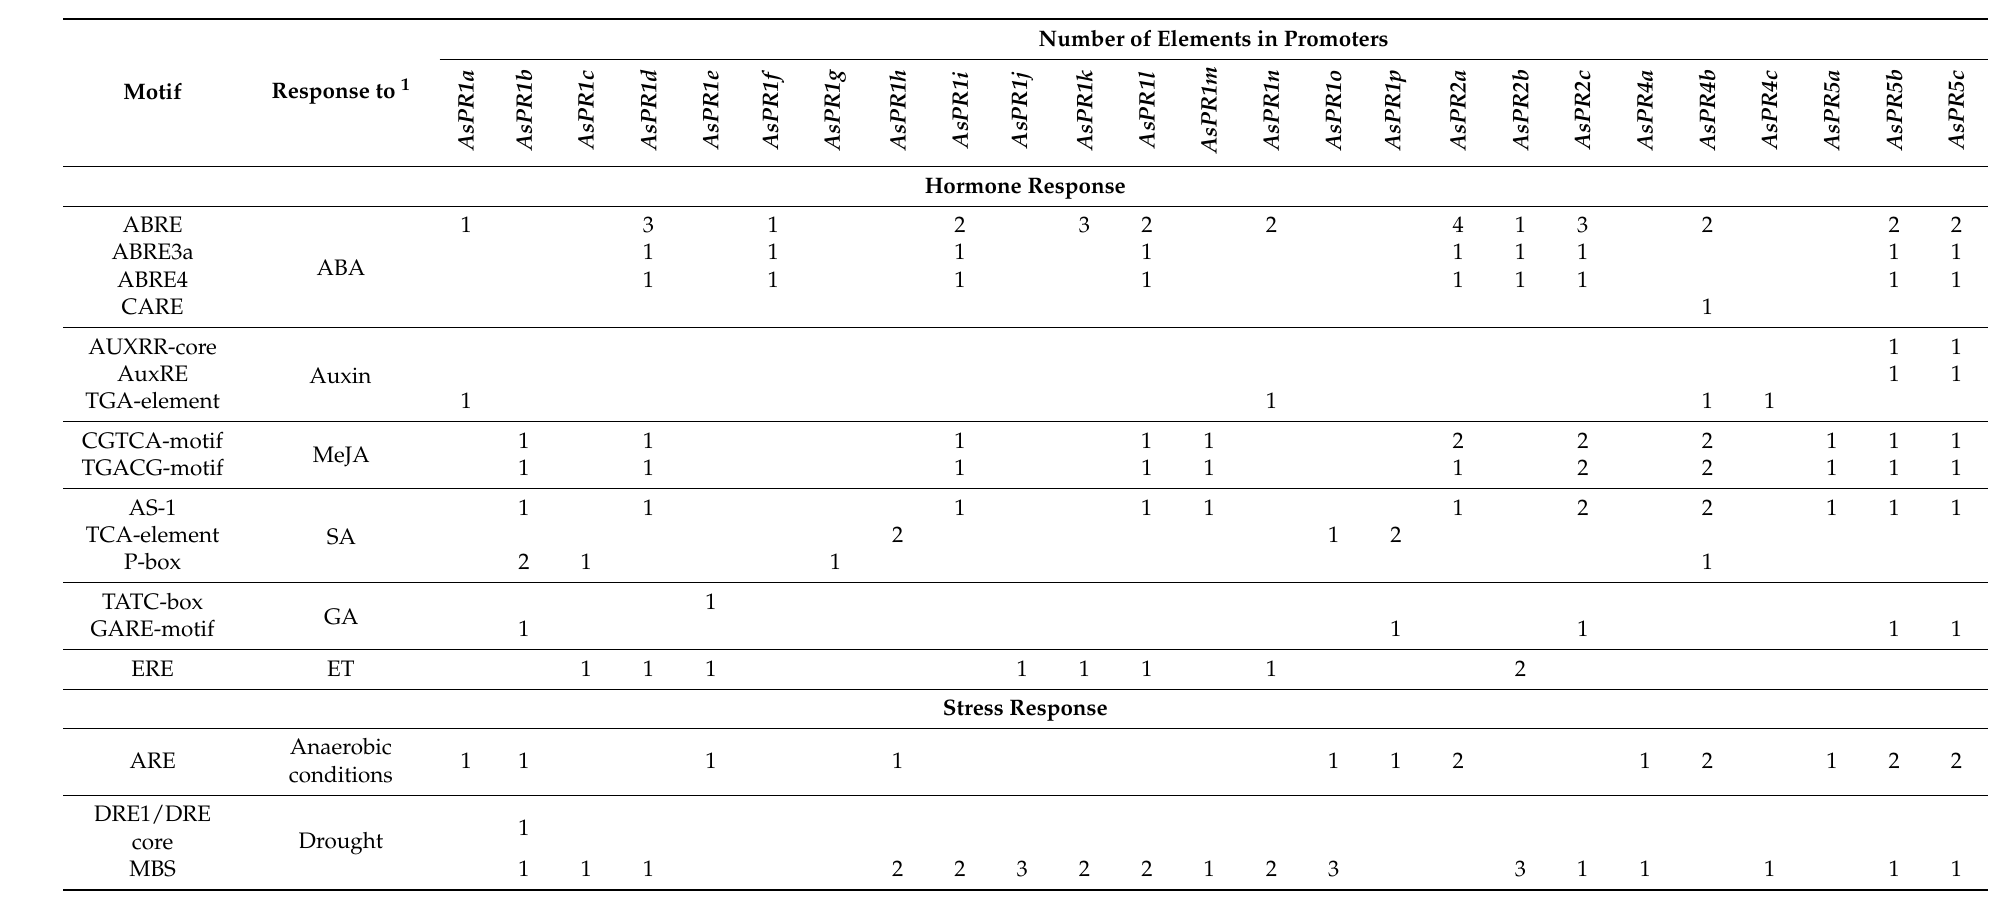
Table 3. Regulatory cis -elements found in silico in the promoters of the PR1 , PR2 , PR4 , and PR 5 genes from Allium sativum cv.